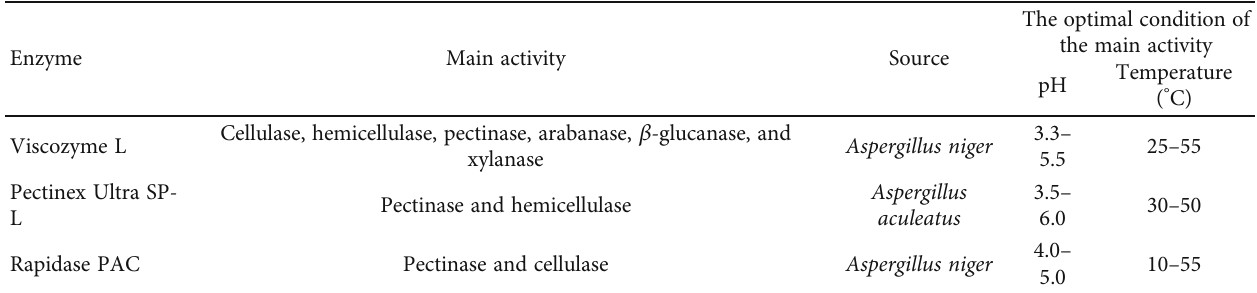
Table 1: Enzymes employed in the experiment a